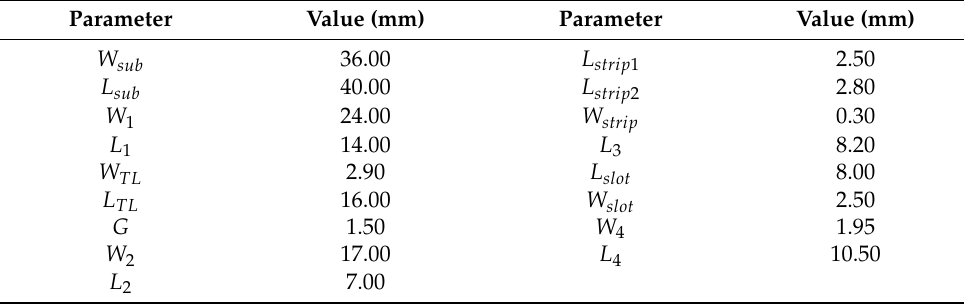
Table 1. Dimensions of the Designed Antenna.